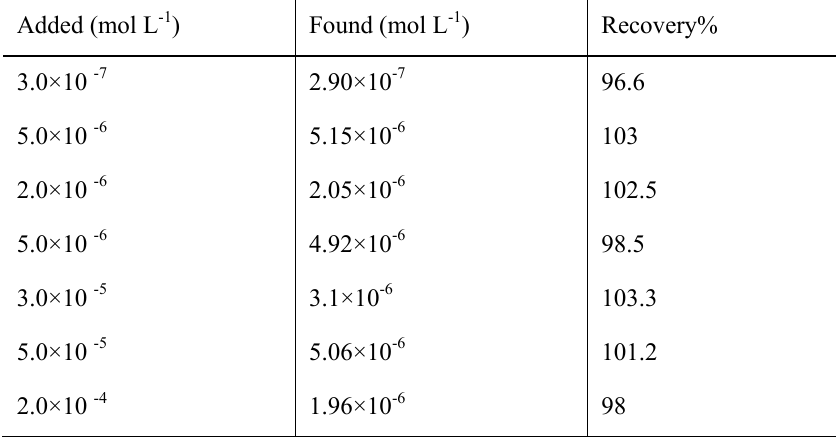
Table1. The recoveries of peroxide hydrogen using present